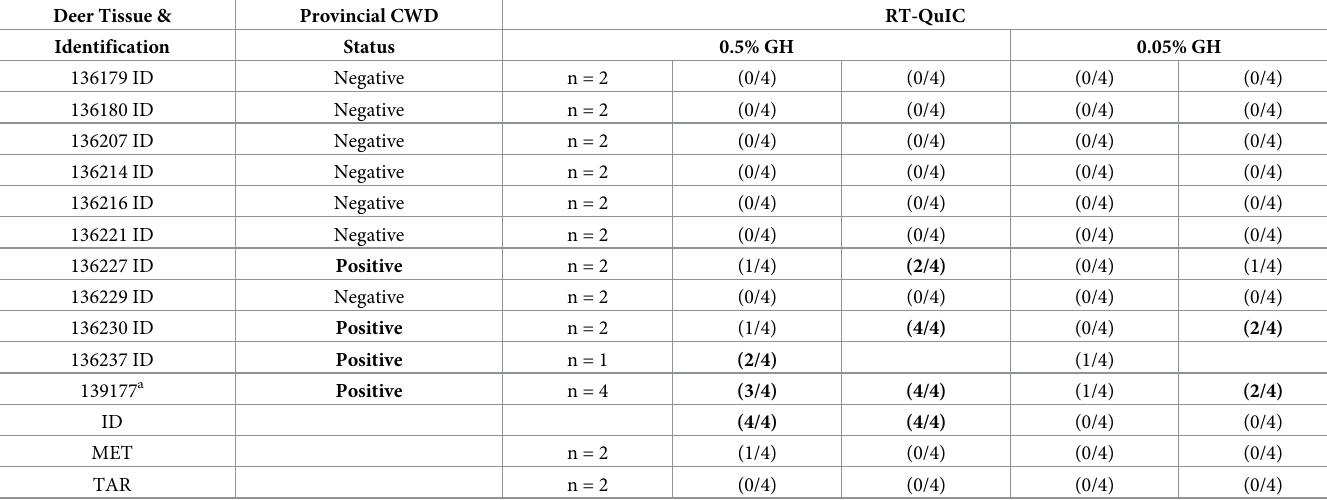
Gland homogenates (GH) (0.5% or 0.05% (w/v)) were tested by RT-QuIC in quadruplicate. Total number of glands tested (n) are shown along with the assay results. Threshold for positivity is 5 standard deviations above average negative controls. Samples with 2 or more positive replicates are bolded. a Individual 139177 was a mule deer that was clinically affected with